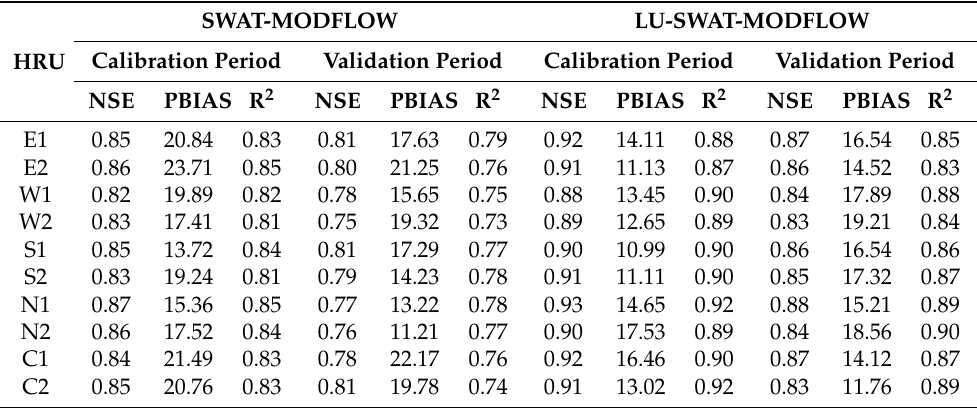
Table 4. Performance of the original SWAT-MODFLOW model versus the LU-SWAT-MODFLOW model in simulating